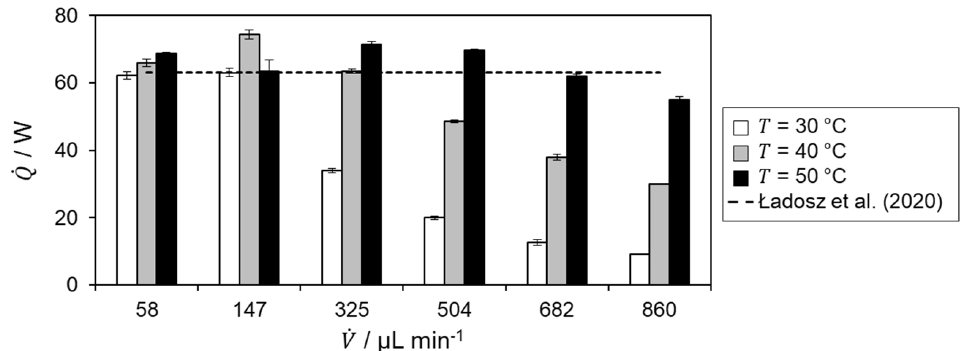
Figure 8. Determined reaction enthalpy for hydrolysis of acetic anhydride from the experiments for the respective volumetric flow rates and temperatures in comparison with literature value by Ładosz et al. [17], which is indicated by a dashed black line.